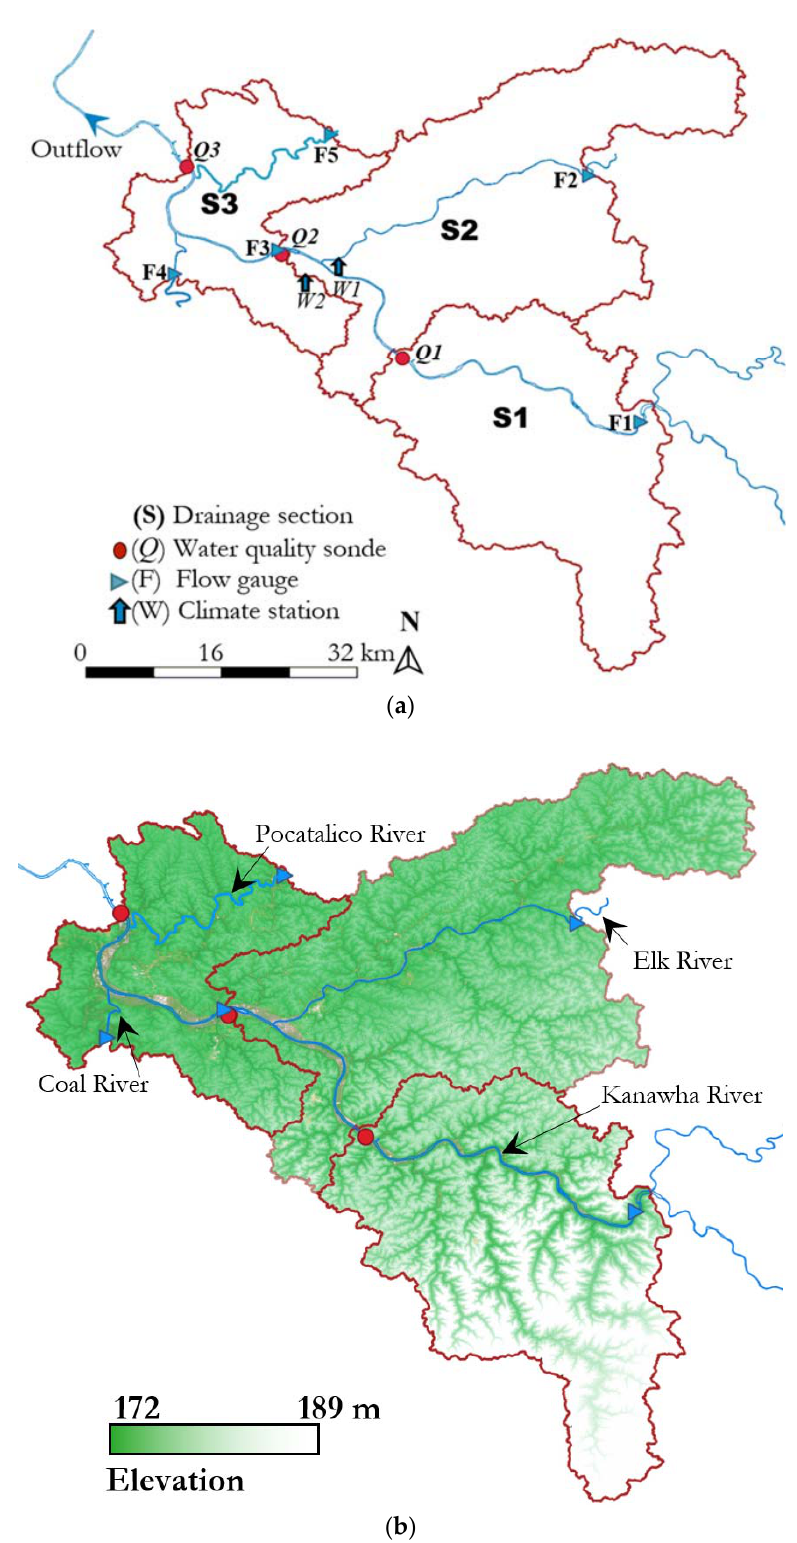
Figure 1. Description of ( a ) the study area and ( b ) drainage area of the Kanawha River, West Virginia, which were delimited by flow gages and water quality monitoring stations specified in Table 1.